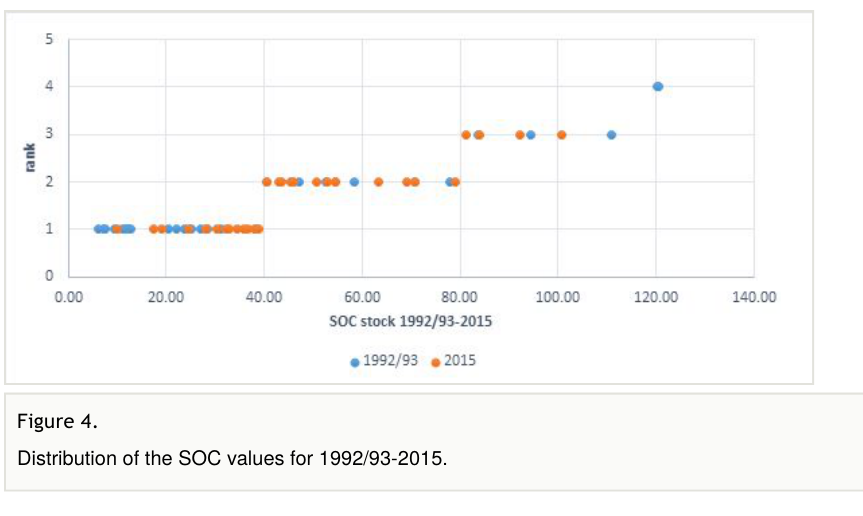
attribute values from 0-140. The datasets for the ICP Level I observation plots were distributed in 5 categories (ranks) from 1-5 (Fig. 4).